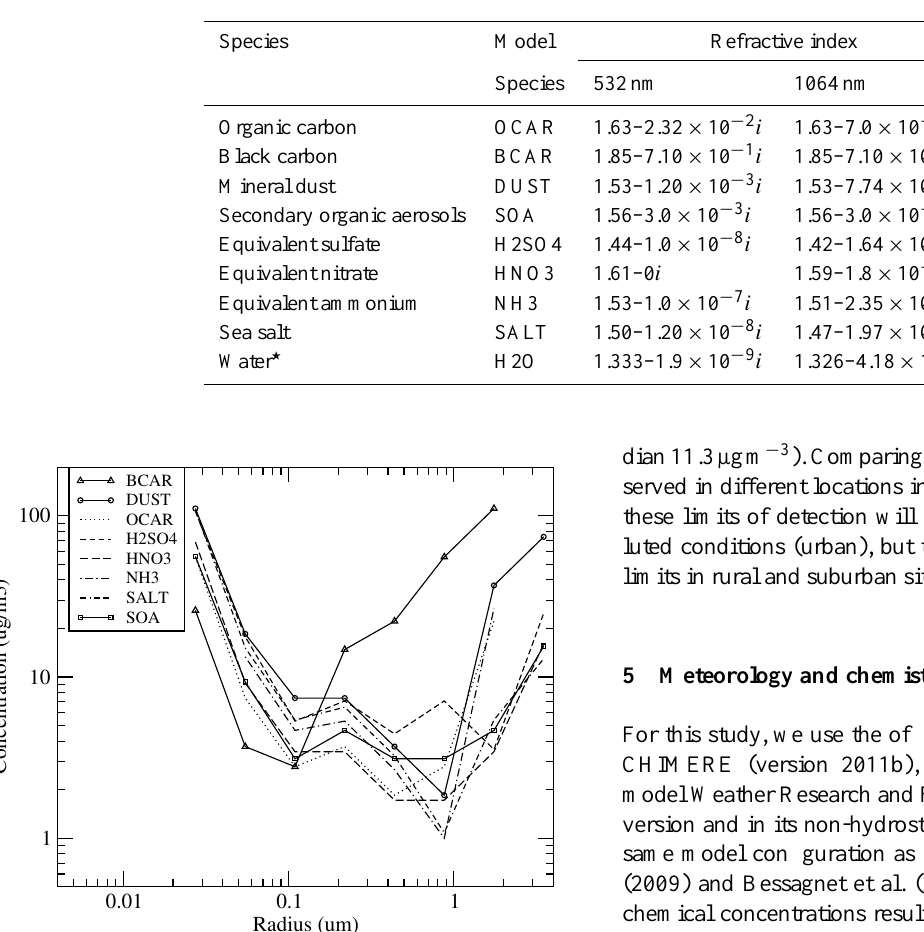
Table 3. List of species accounted for by the CHIMERE optical module, wavelength-dependent complex refractive index and density of each aerosol species. All refractive indices and density values are taken from the ADIENT/APPRAISE technical report (http://www.met.reading. ac.uk/adient/).